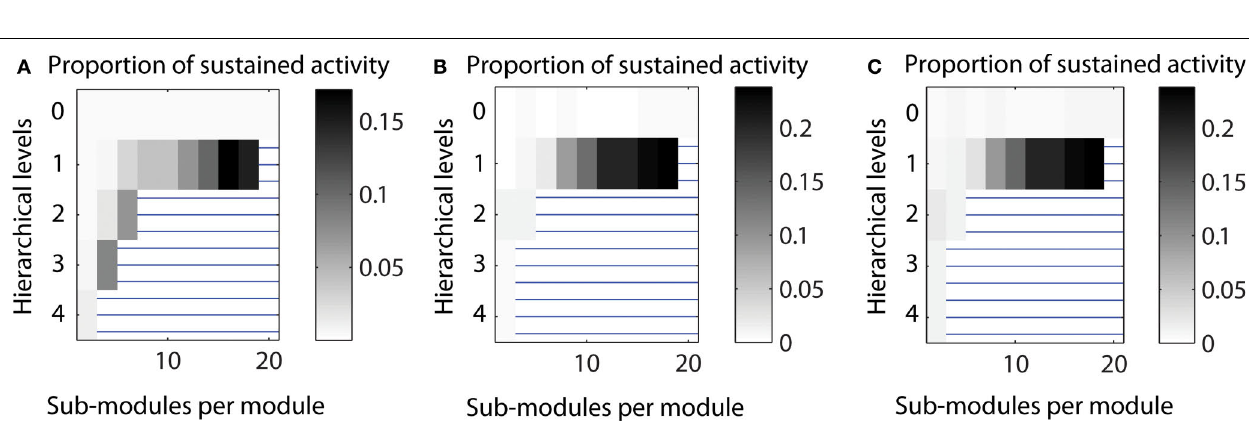
FIGURE 11 | Varying the edge density in a network with 512 nodes. (A) Decreased edge density d = 5%, average node degree 〈 k 〉 = 25. (B) Original edge density d = 10%, average node degree 〈 k 〉 = 50. (C) Increased edge density d = 20%, average node degree 〈 k 〉 =